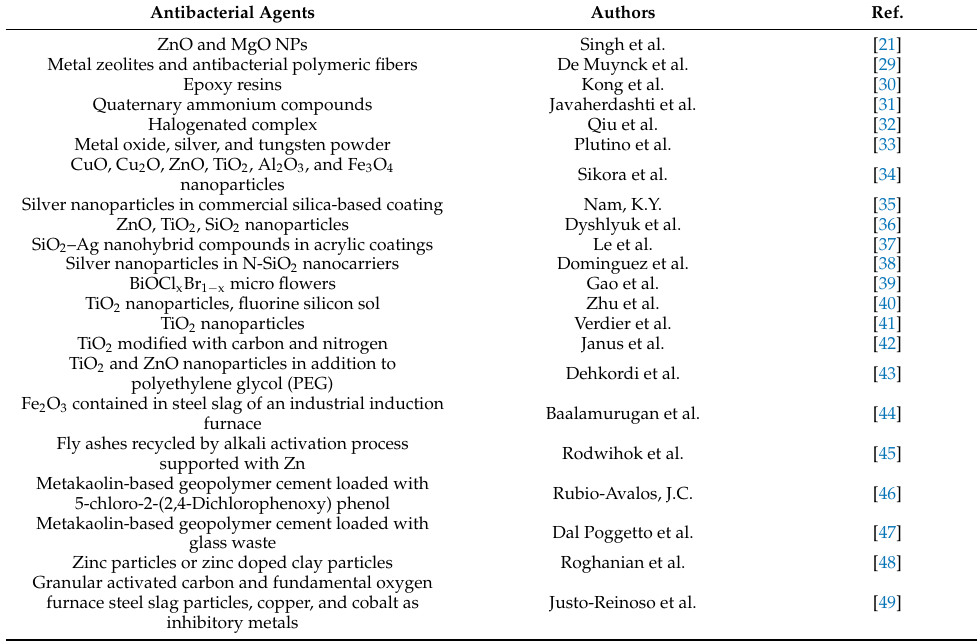
Table 1. List of the common antibacterial agents used to preserve cement structures. Antibacterial